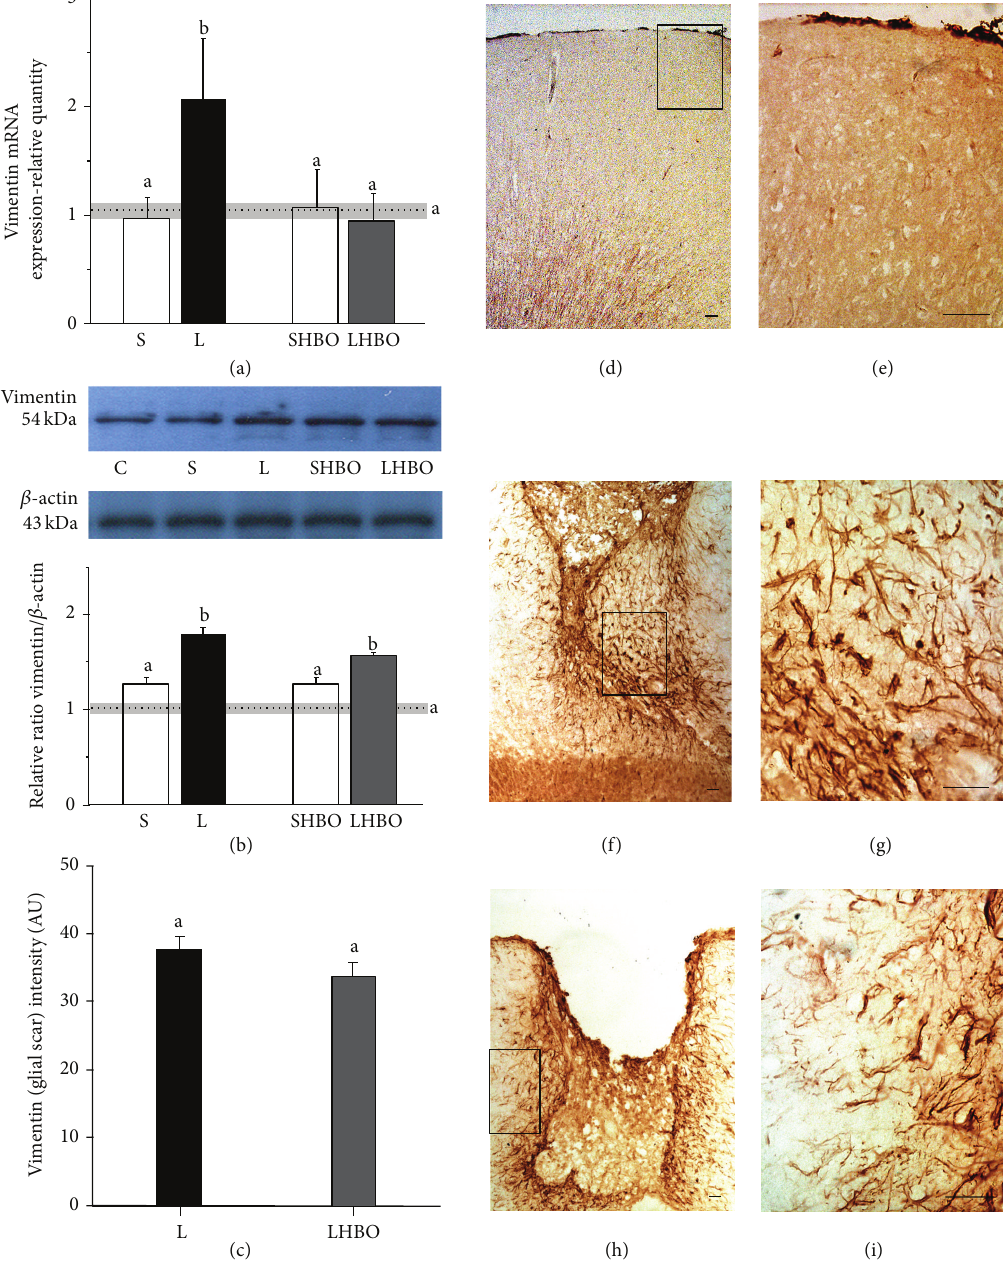
Figure 2: Repetitive HBOT reduces gene and tissue expression of vimentin after CSI. Upregulation of vimentin expression both at mRNA (a) and protein (b) levels is observed after CSI in the injured cortex compared to intact control and sham-operated animals. (a) Repetitive HBOT reduced levels of vimentin mRNA to those detected in control groups. Bars represent mean ± SEM of vimentin mRNA (relative to GAPDH). (b) Immunoblot analysis showed that vimentin was present as a single band with a molecular mass of about 57 kDa. HBOT slightly but not statistically significantly decreased vimentin expression. Bars represent mean ± SEM of vimentin protein content (relative to 𝛽 -actin). Samples are from 4 animals per each group. Dot line represents mean of vimentin mRNA or protein level ± SEM (gray area) measured in control animals. Letters indicate significance levels ( 𝑃 < 0.005 ) between lesioned (L) and intact control groups, L versus sham control (S) group, and L compared to lesioned group subjected to the HBO protocol (LHBO). The groups not sharing a common letter are statistically different. Level of significance was analyzed using Student’s 𝑡 -test. (c) The luminosity of glial scar is obtained by measuring vimentin staining intensity around the lesion site and presented on histogram. ((d) and (e)) Vimentin immunoreactivity was negligible in the cortex of intact rats. ((f) and (g)) After CSI vimentin staining was significantly increased in the proximity to the lesion site. Vimentin + astrocytes had enlarged cell bodies with thick processes. ((h) and (i)) After HBOT reactive astrocytes surrounded the lesion site as a narrow line. Rectangles indicate where the high magnification images are taken from. Scale bar = 50 𝜇